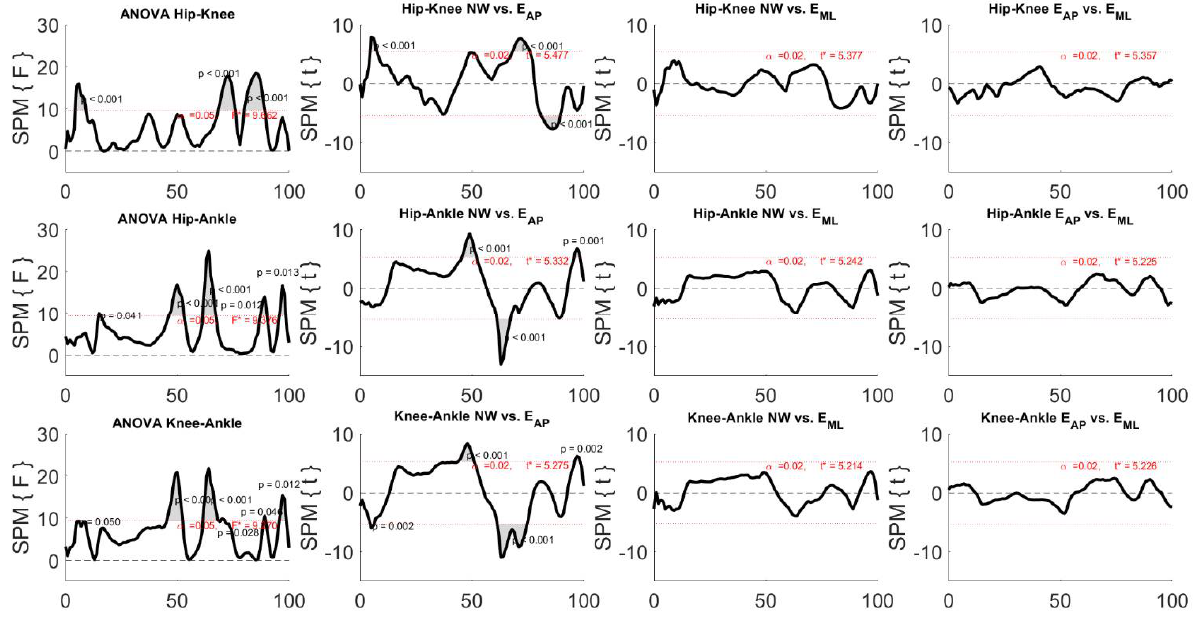
Figure 7. Results of the one-way repeated measurement ANOVA SPM and related post-hoc analysis for CRP curves. Black, bold lines indicate the statistical maps, the dotted, red lines indicate the critical threshold, and the grey areas indicate the significant difference among independent variables, i.e., the three motion tasks. F* and t* indicate the F-value and t-value for ANOVA and t-tests,